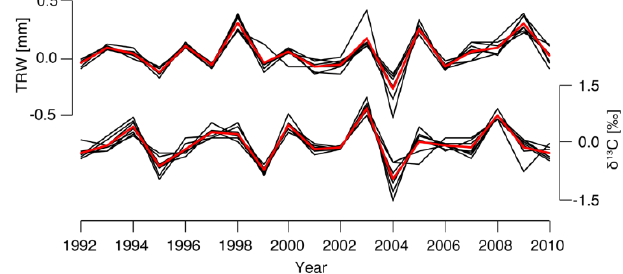
Figure 7. High frequency TRW and δ 13 C variability. Top panel shows first-differenced TRW disc mean curves (DMCs) at seven tree heights (black) together with their arithmetic mean (red). Bottom panel shows the first- differenced δ 13 C DMCs and mean.